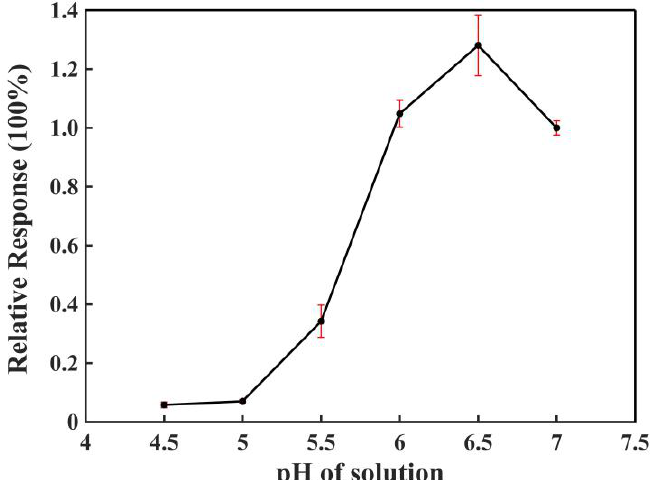
Figure 10. Effect of pH on the detection of lactate based on a three-electrode sensing system. Vertical ordinates: The relative signal response was obtained by normalizing the sensing responses under different pH conditions to the sensing performance under pH 7.0. Lactate concentration: 0.1 mM.